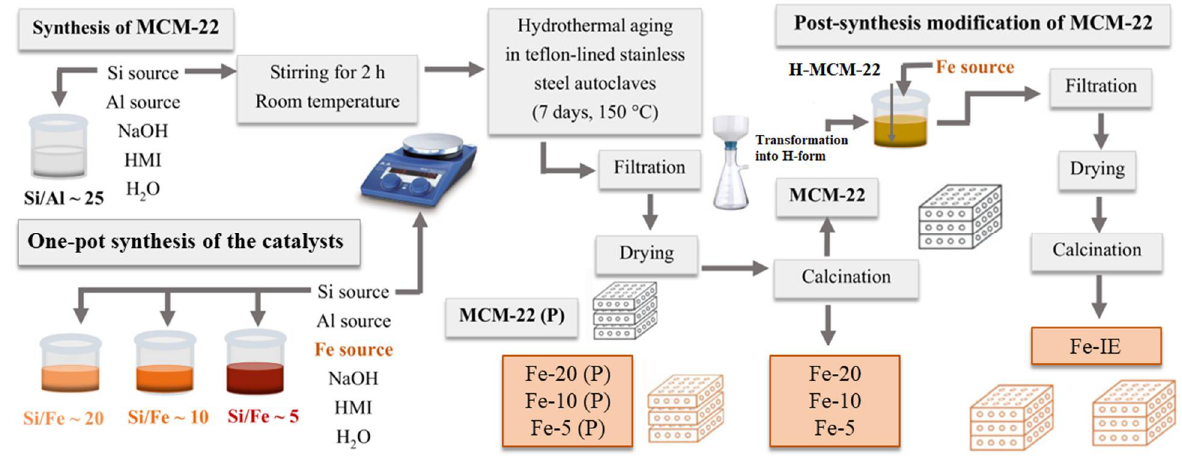
Figure 14. Schematic representation of the catalyst synthesis procedure.